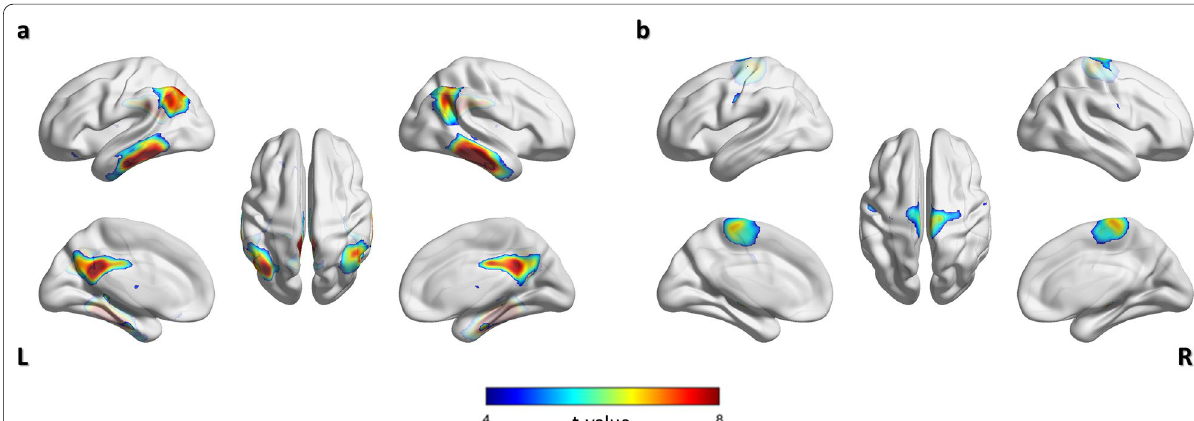
Fig. 5 Result of voxel-wise 2-[ 18 F]FDG PET analysis performed in the ADNI and KBASE datasets. a) Areas of higher glucose metabolism in Aβ-negative PET scan participants compared to Aβ-positive PET scan participants. b) Areas of higher glucose metabolism in Aβ-positive PET scan participants compared to Aβ-positive PET scan participants. All results are presented with a threshold of p < 0.05, FWE-corrected, and 50 voxels. Abbreviation: ADNI Alzheimer’s Disease Neuroimaging Initiative; KBASE Korean Brain Aging Study for the Early diagnosis and prediction of = = Alzheimer’s disease; FDG